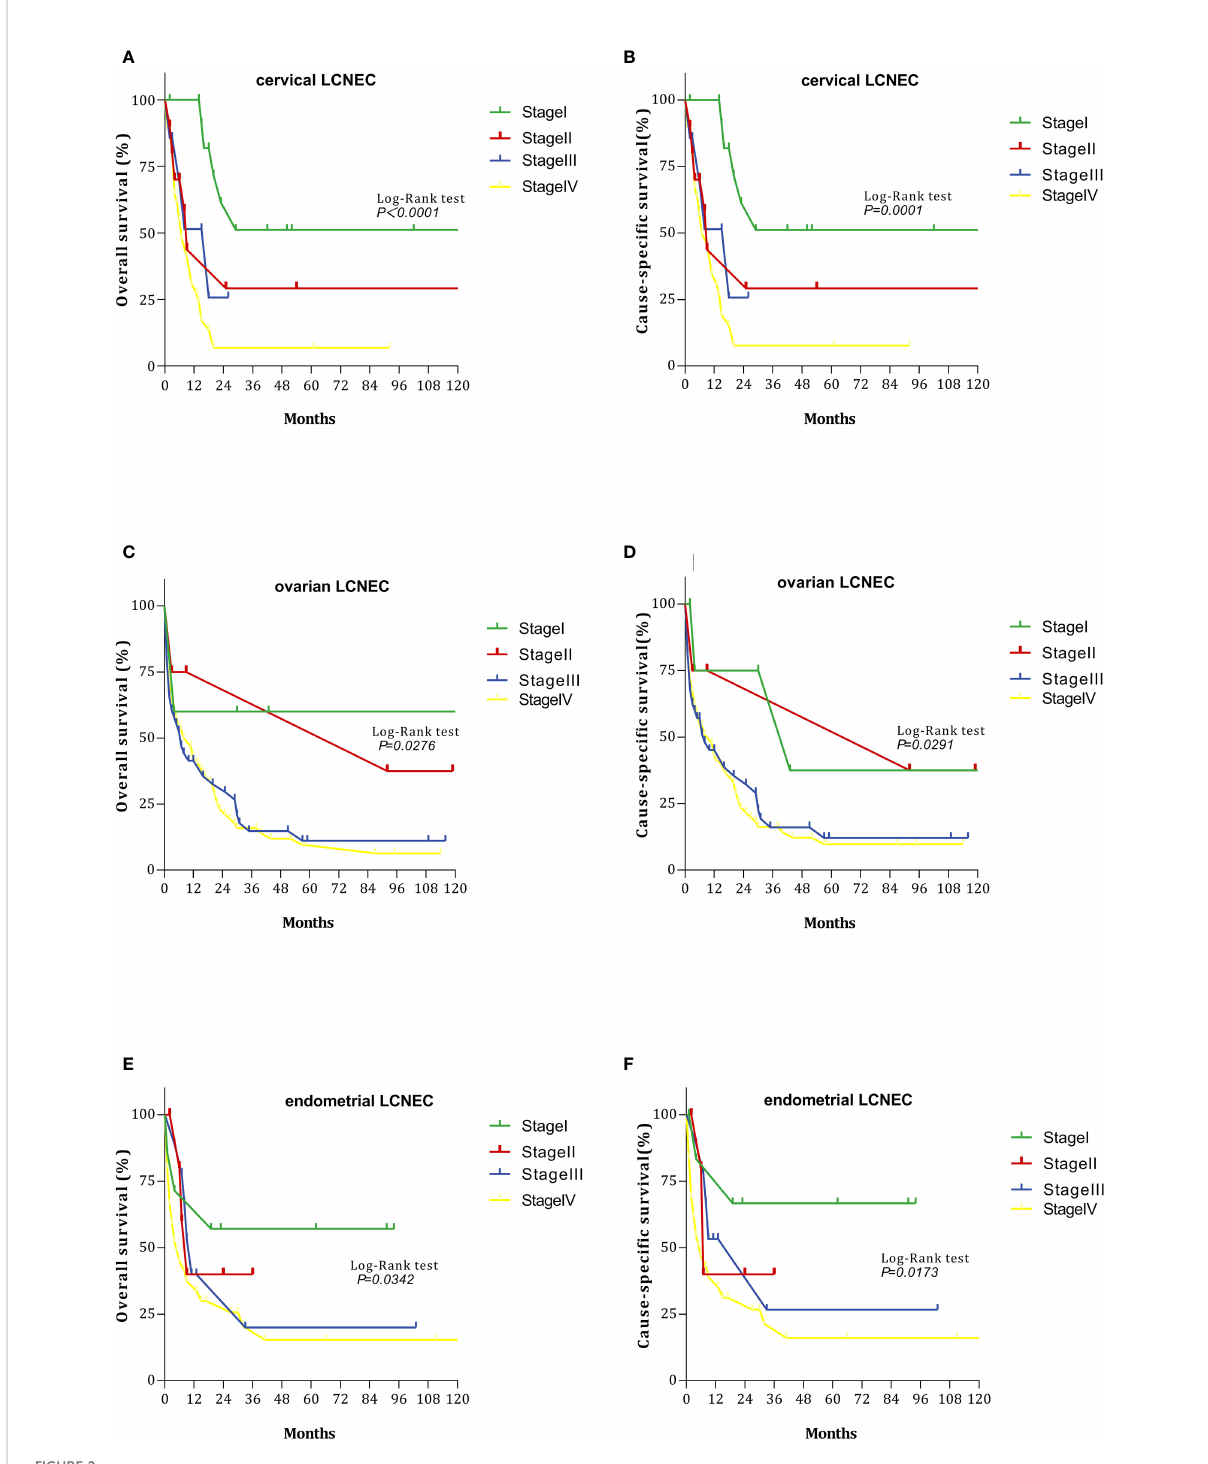
FIGURE 2 Survival curves with cervical, ovarian, and endometrial LCNEC at each stage: (A) overall survival (OS)with cervical LCNEC; (B) cancer-speci fi c survival (CSS)with cervical LCNEC. (C) overall survival (OS)with ovarian LCNEC; (D) cancer-speci fi c survival (CSS)with ovarian LCNEC; (E) overall survival (OS)with endometrial LCNEC; (F) cancer-speci fi c survival (CSS)with endometrial